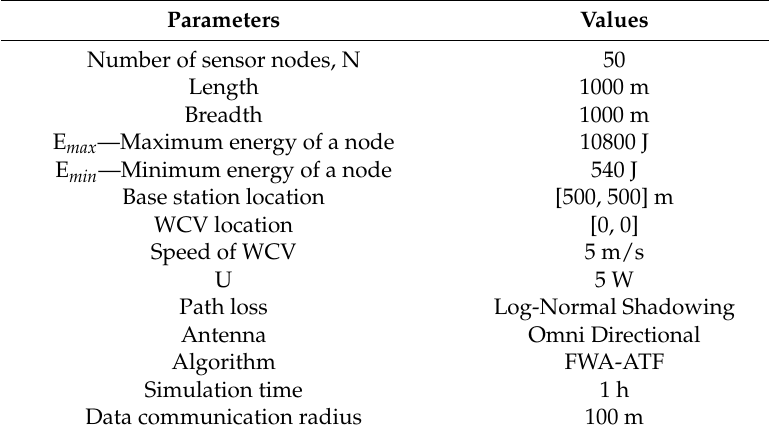
Table 2. Simulation parameters [23–25].